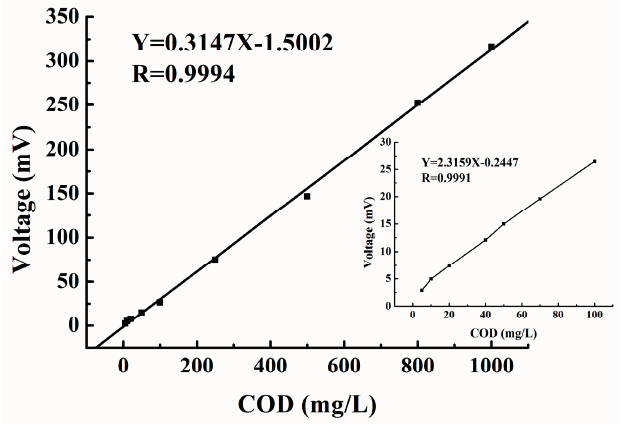
Figure 4. Calibration curve for standard glycine samples. Data represent the average of three measurements.